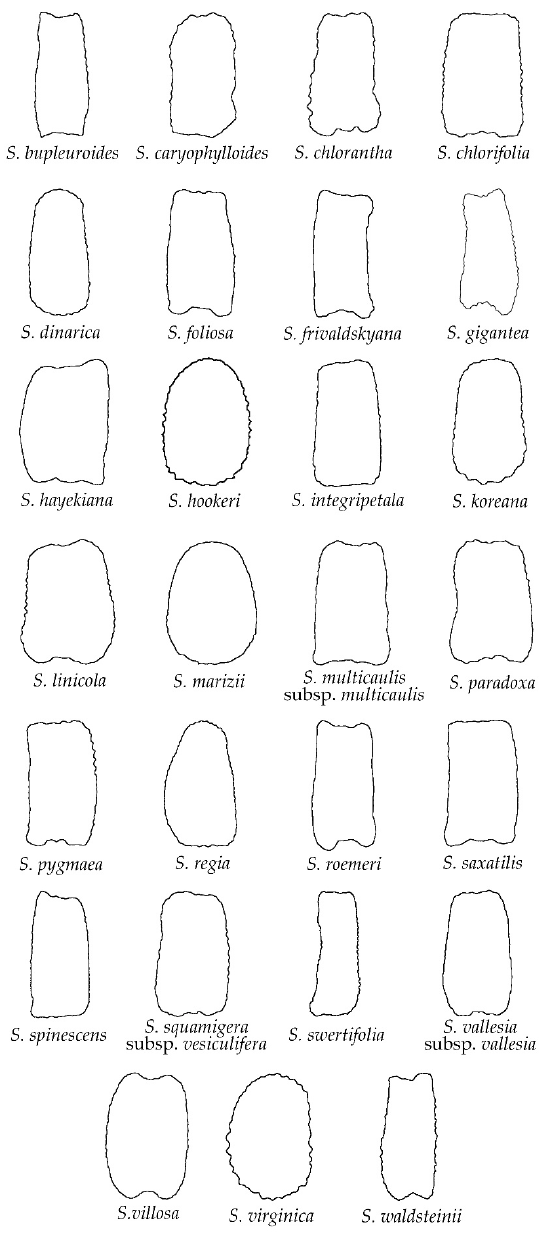
Figure 4. Silhouettes of the dorsal view of seeds in the group of rugose outline. The group of echinate seeds is formed by the following 16 species (Figure 5): S. aprica , S. chungtienensis , S. ciliata , S. dichotoma , S. fabaria , S. firma , S. fruticosa , S. jeniseensis , S. longicilia , S. multiflora , S. nana , S. petersonii , S. samojedorum , S. suksdorfii , S. viridiflora and S. yunannensis . Most of the species in this group belong to S. subg. Behenantha (10 species